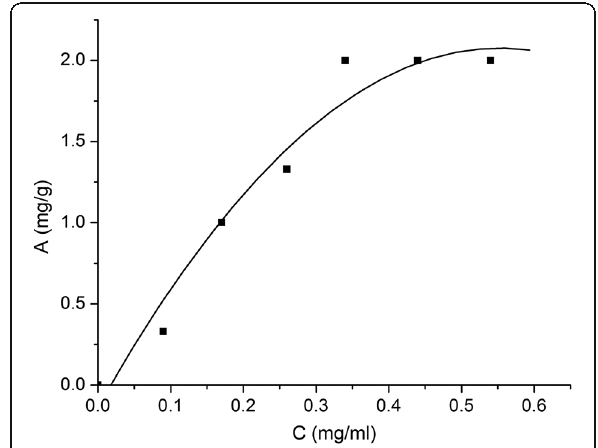
Fig. 5 Adsorption isotherm of HEMA on the nanosilica surface from aqueous